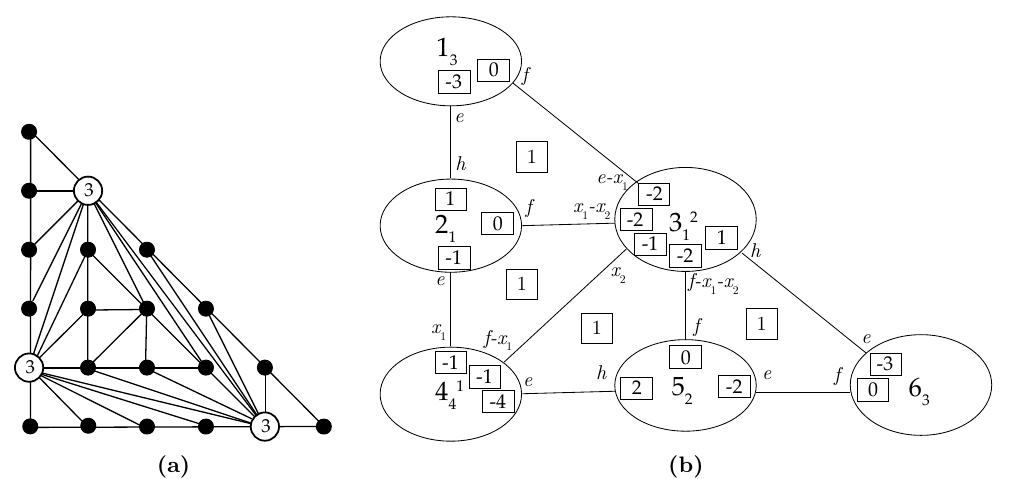
Figure 10 . A descendant SCFT of the T 5 theory, with a triangle-shaped CFD with three (+3) curves. We refer to this theory as B 5 . The left hand side shows the toric triangulation and the right hand side the surface con(cid:12)gurations in terms of glued blowups of F m